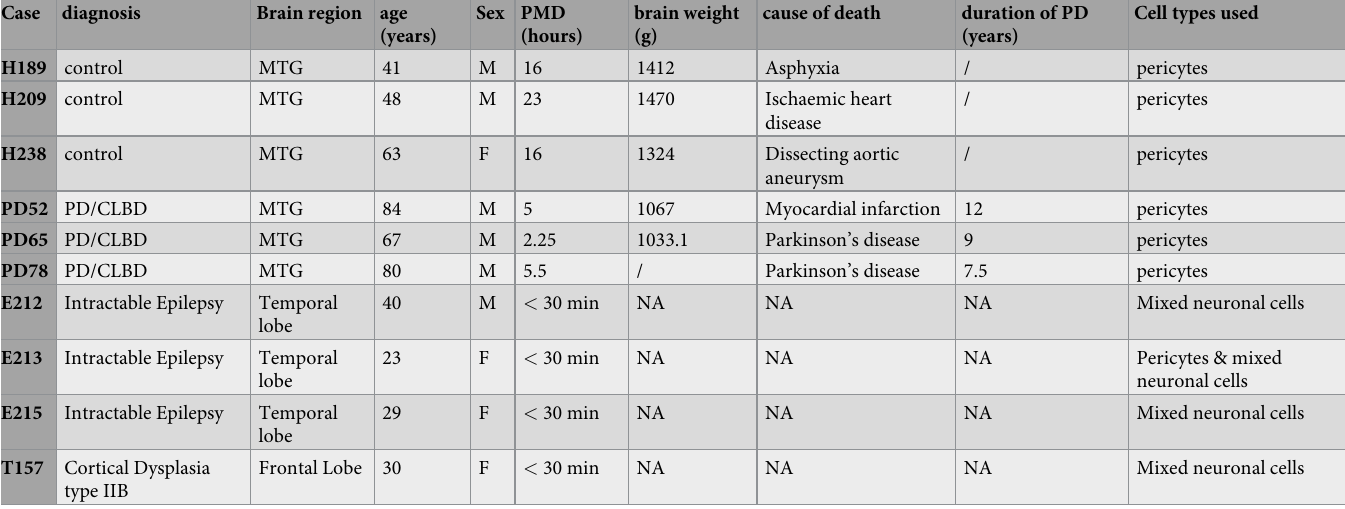
Table 1. Case information for post-mortem and surgical removedbrain tissue used in this study. Case